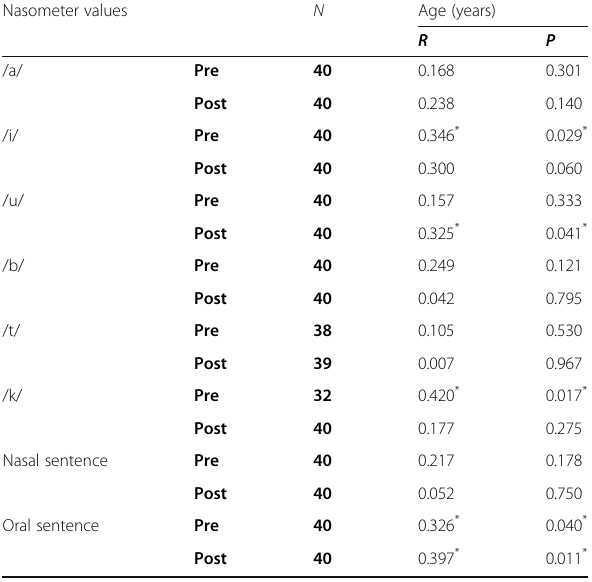
Table 8 Correlation between degree of auditory perceptual assessment of speech before intervention and degree of